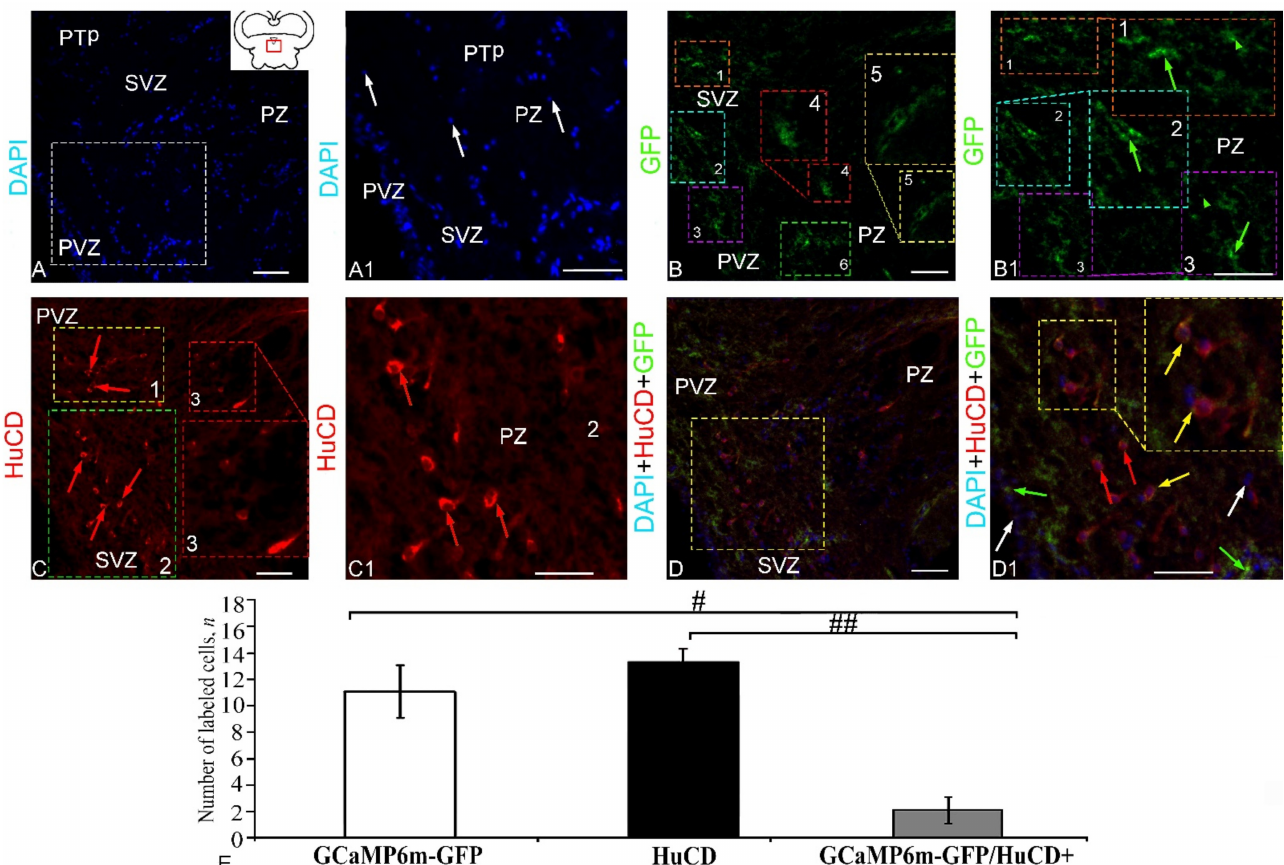
Figure 10. Z-stacks showing DAPI staining, localization of GFP and HuCD, and their co-localization in the posterior tubercle of juvenile chum salmon, O. keta , at 90 days after a single injection of the rAAV into the cerebellar body. ( A ) DAPI staining with a pictogram showing the posterior tuberculum pars posterium (PTp) area in a red box; a dotted white box outlines the accumulation of DAPI-stained posterior tuberculum nuclei; PVZ, periventricular zone; SVZ, subventricular zone; PV, periventricular zone. ( A1 ) The enlarged fragment outlined by a white dotted box in A; stained nuclei (white arrows). ( B ) Expression of the green fluorescent protein GFP in populations of neurons (1–6) of the posterior tuberculum. Insets 4 and 5 show the enlarged fragments of the corresponding populations. ( B1 ) The enlarged fragments of populations 1, 2 and 3 (insets) in B; GFP+ cells (green arrows) and GFP+ granules (green arrowheads). ( C ) Immunofluorescence of HuCD in neuronal populations 1 and 2 (red arrows), population 3 (red inset). ( C1 ) The enlarged fragment of population 2 inn C; HuCD+ cells (red arrows). ( D ) Optical overlay of three DAPI/GFP/HuCD staining channels showing areas of GFP/HuCD co-localization in neurons (dashed yellow square). ( D1 ) The enlarged fragment outlined by a yellow dotted box in D, showing co-localization of GFP and HuCD (yellow arrows in inset), HuCD+ neurons (red arrows), DAPI-stained nuclei (white arrows), and GFP+ neurons (green arrows). Laser scanning confocal microscopy. Scale bar: ( A , B , C , D ) 100 µ m; ( A1 , B1 , C1 , D1 ) 50 µ m. ( E ) One-way ANOVA showing the relative distribution of GFP and HuCD immunolabeled cells (M ± SD) in the posterior tuberculum region of juvenile chum salmon, O. keta . Significant intergroup differences were found in GCaMP6m-GFP and GCaMP6m-GFP/HuCD (# <0.05) ( n = 5 in each group) and in HuCD and GCaMP6m-GFP/HuCD (## <0.01) groups ( n = 5 in each group). The one-way ANOVA for distribution revealed the presence of intergroup differences in the proportions of immunopositive GFP+ and GFP+/HuCD+ cells ( p ≤ 0.05), as well as significant intergroup differences in the distribution of HuCD+ and GFP+/HuCD cells ( p ≤ 0.01) (Figure 10F). The percentage of GFP+ and GFP+/HuCD+ cells is presented